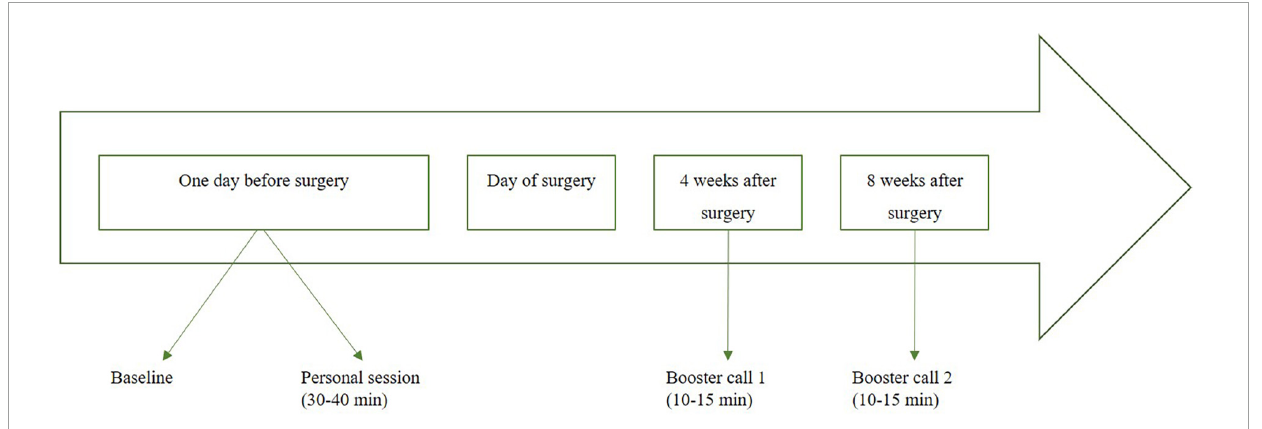
FIGURE2 Intervention schedule for EXPECT [adapted from Laferton et al. (26), Salzmann et al. (57)].